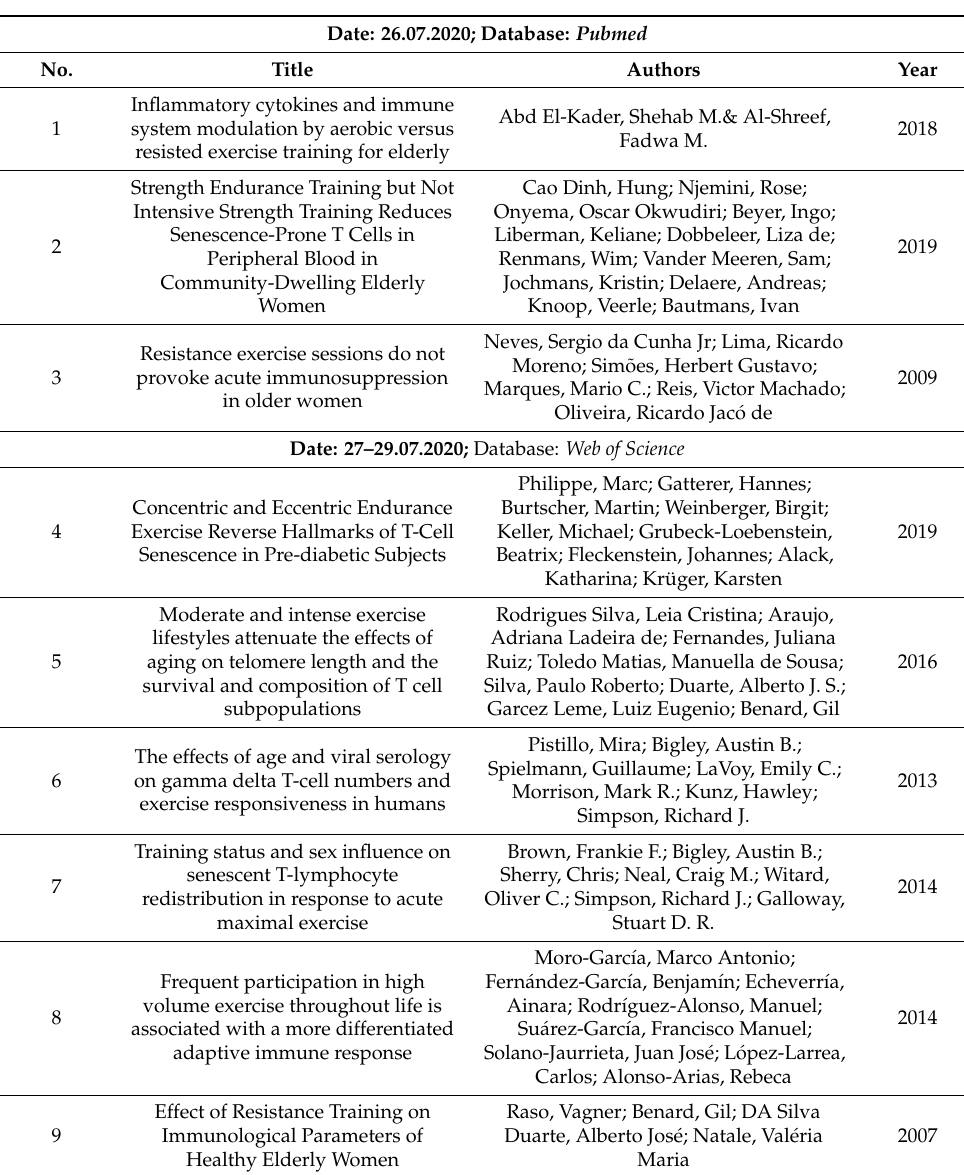
Table A1. Database research of included